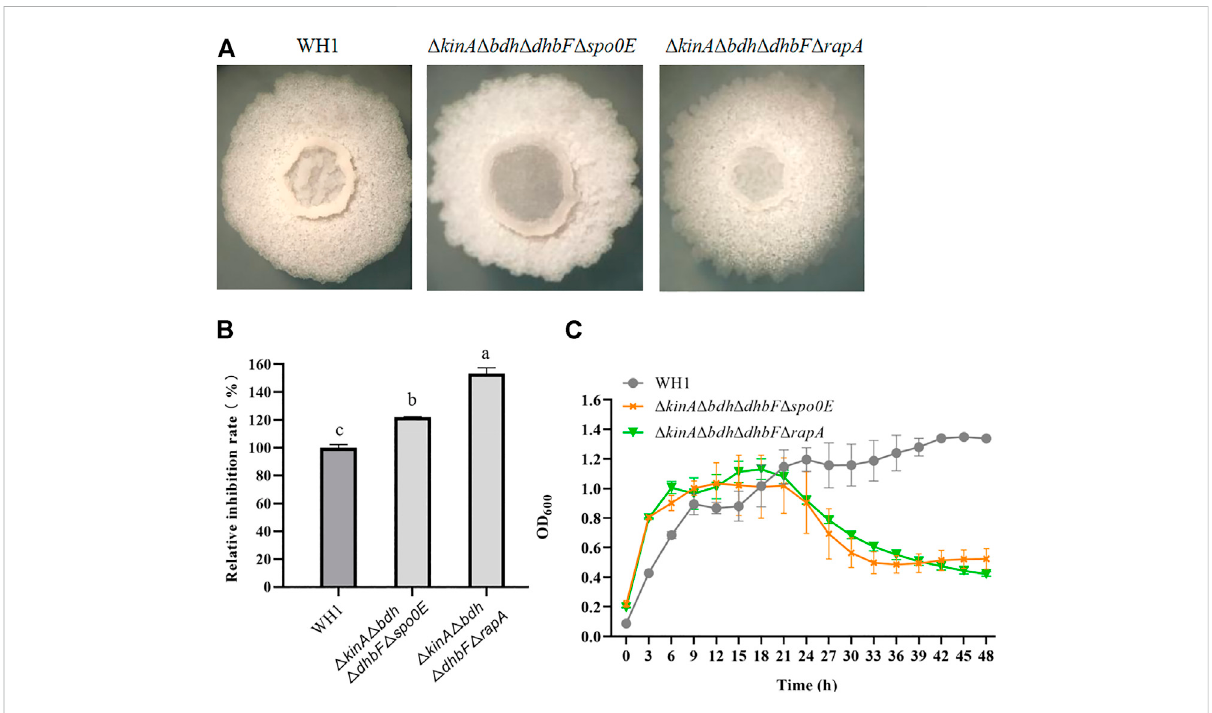
FIGURE 8 Relative inhibition rates and characteristics of quadruple knockout strains. (A) : Colony morphology; (B) : Relative inhibition rates; (C) : Growth